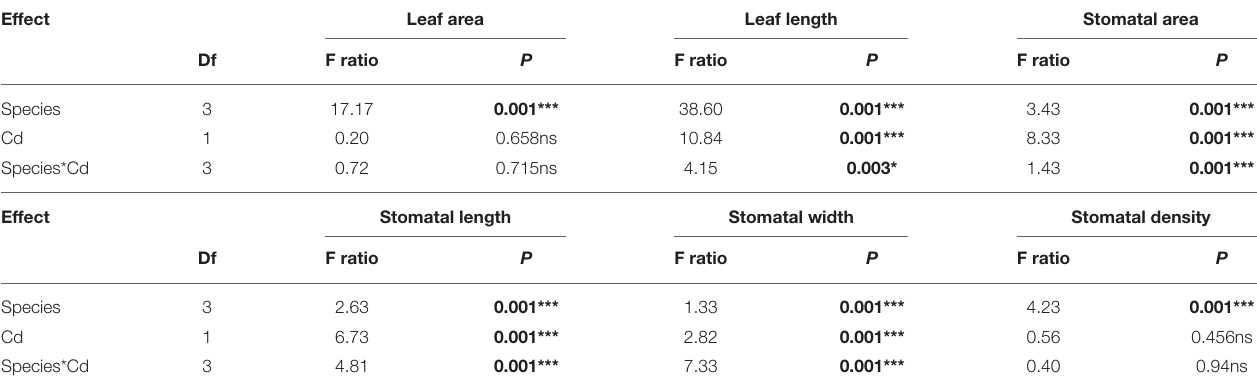
TABLE 1 | Two-way ANOVA analysis of effects of Cd stress on leaf functional traits of invasive and native plants.